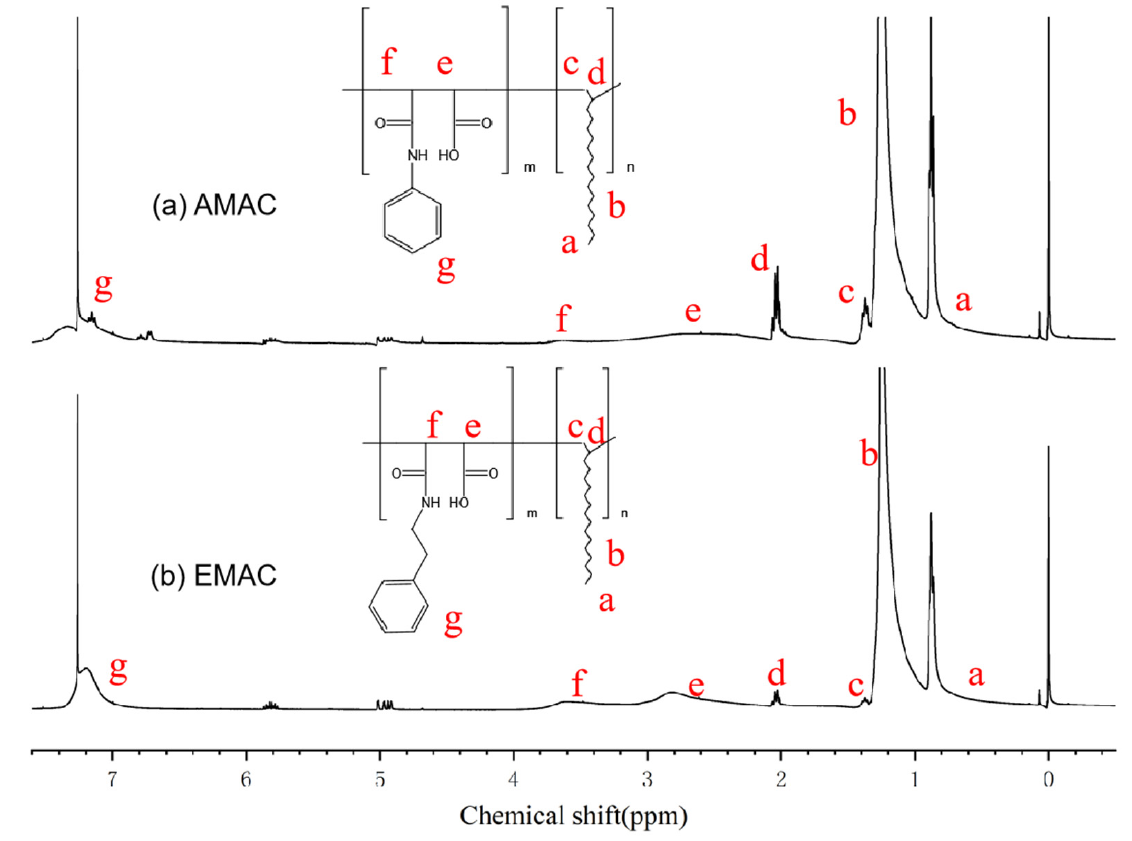
Figure 5. 1 HNMR spectra of AMAC and EMAC.